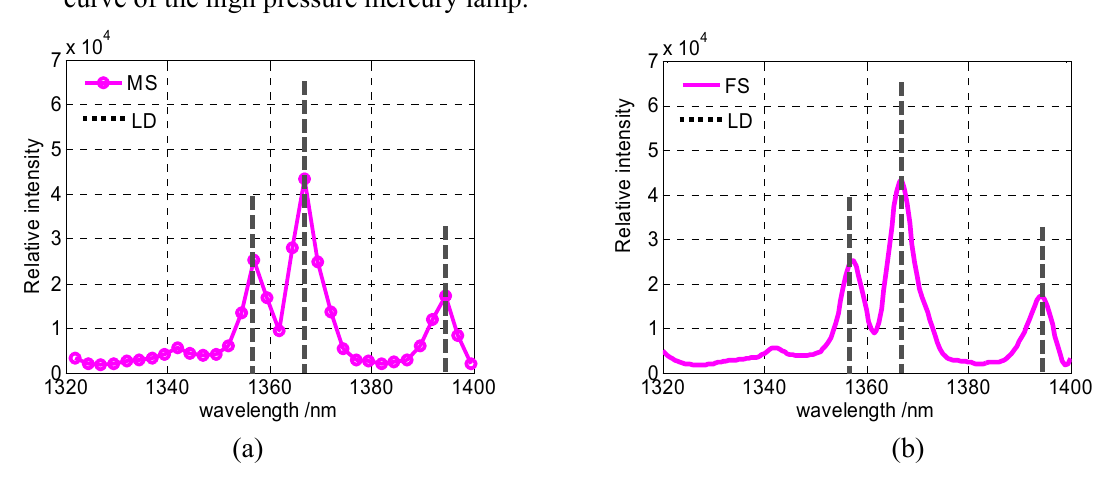
Figure 8. (a) Sampling spectrum of the high pressure mercury lamp. (b) Fitting spectrum curve of the high pressure mercury lamp.